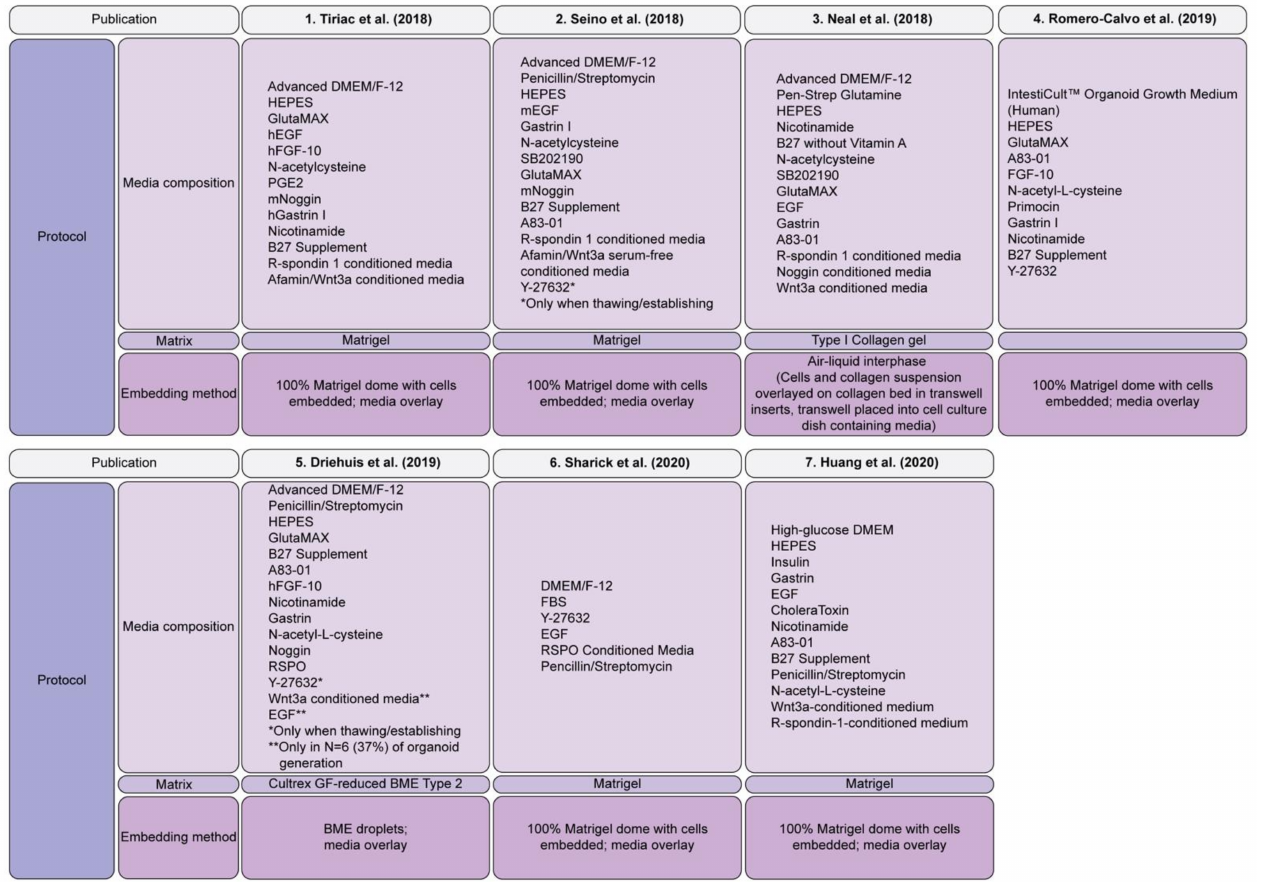
Figure 2. PDAC organoid culture methods. Summary of the protocols utilized by the seven PDAC organoid biobanks described to date [47–53]. Abbreviations: Media Composition: DMEM: Dulbecco’s Modified Eagle Medium; hEGF, human recombinant epidermal growth factor; mEGF, mouse recombinant epidermal growth factor; hFGF-10, human recombinant fibroblast growth factor-10; PGE-2, prostaglandin E2; mNoggin, mouse recombinant Noggin, hGastrin I, human recombinant Gastrin